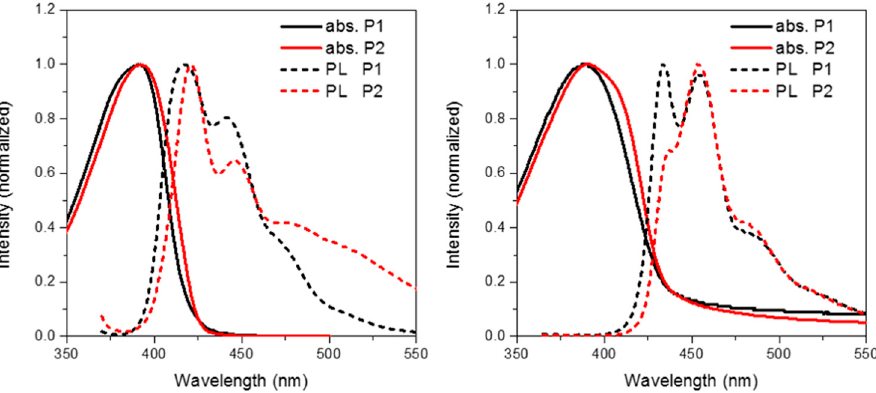
Figure 4. Solution ( left ) and thin film ( right ) absorption and emission spectra of P1 and P2 .